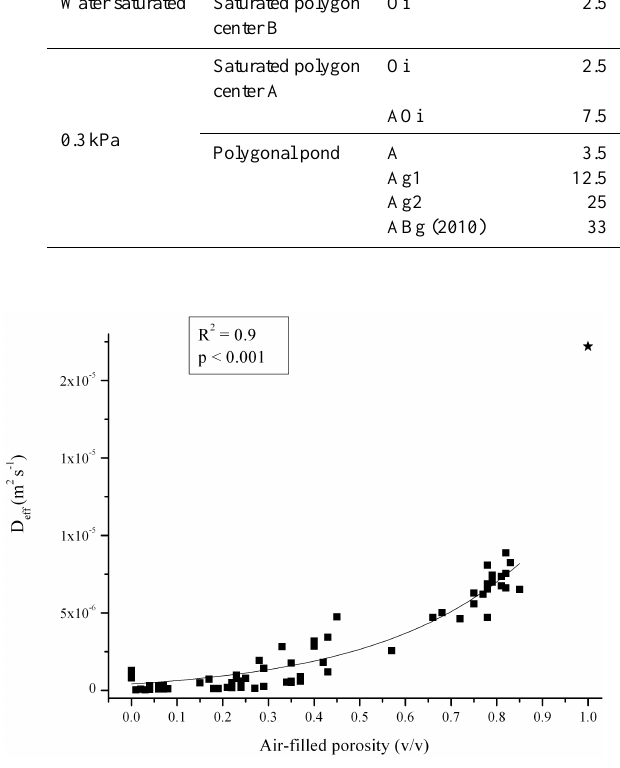
Fig. 1. Relationship between air-filled porosity and soil gas diffusion (effective diffusion coefficient) with exponential fit, n = 64. Star marks diffusion coefficient of CH 4 ( D = 2 . 2 × 10 − 5 m 2 s − 1 ) in free air at 20 ◦ C and 101.33kPa given by Coward and Georgeson (1937).